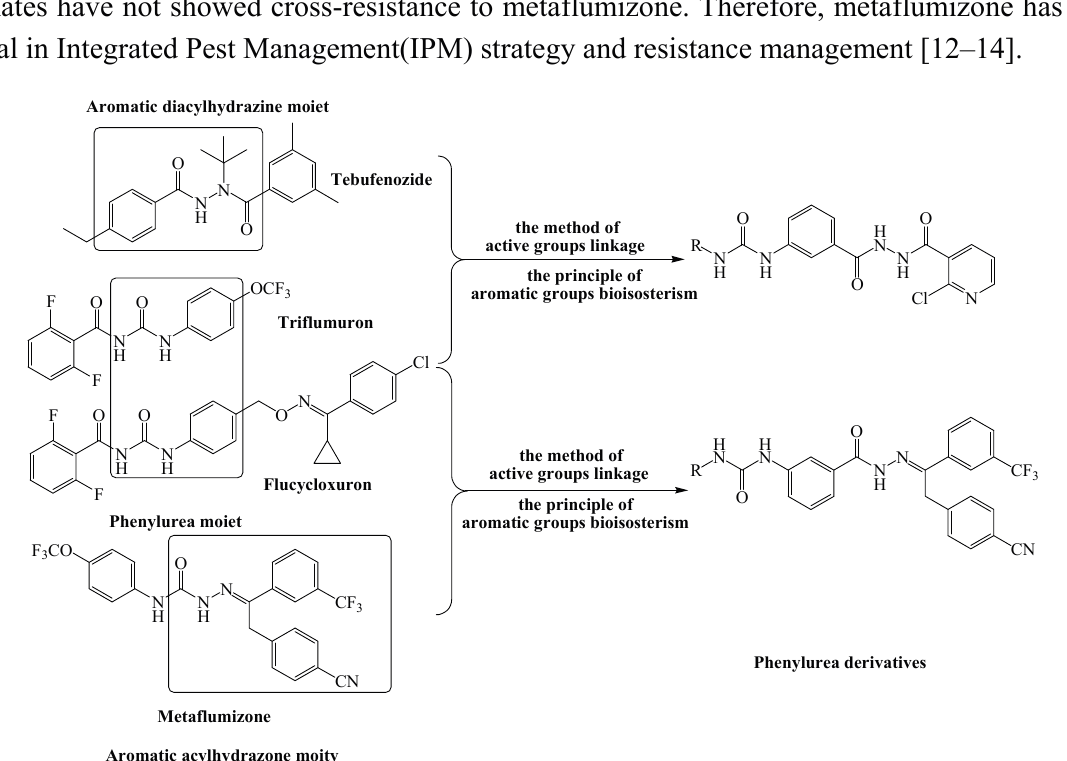
Figure 1. Design of the skeleton of phenylurea